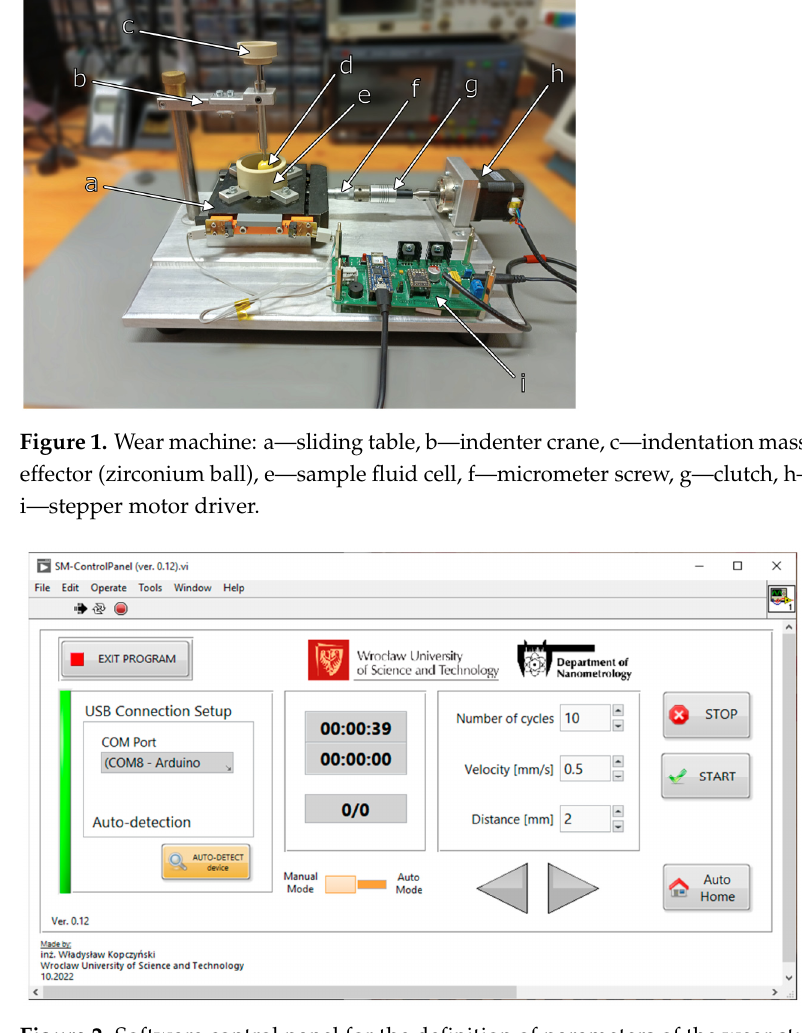
Figure 2. Software control panel for the definition of parameters of the wear study. A zirconium (Zr) ball with a diameter of 30 mm was used as a wear probe, attached